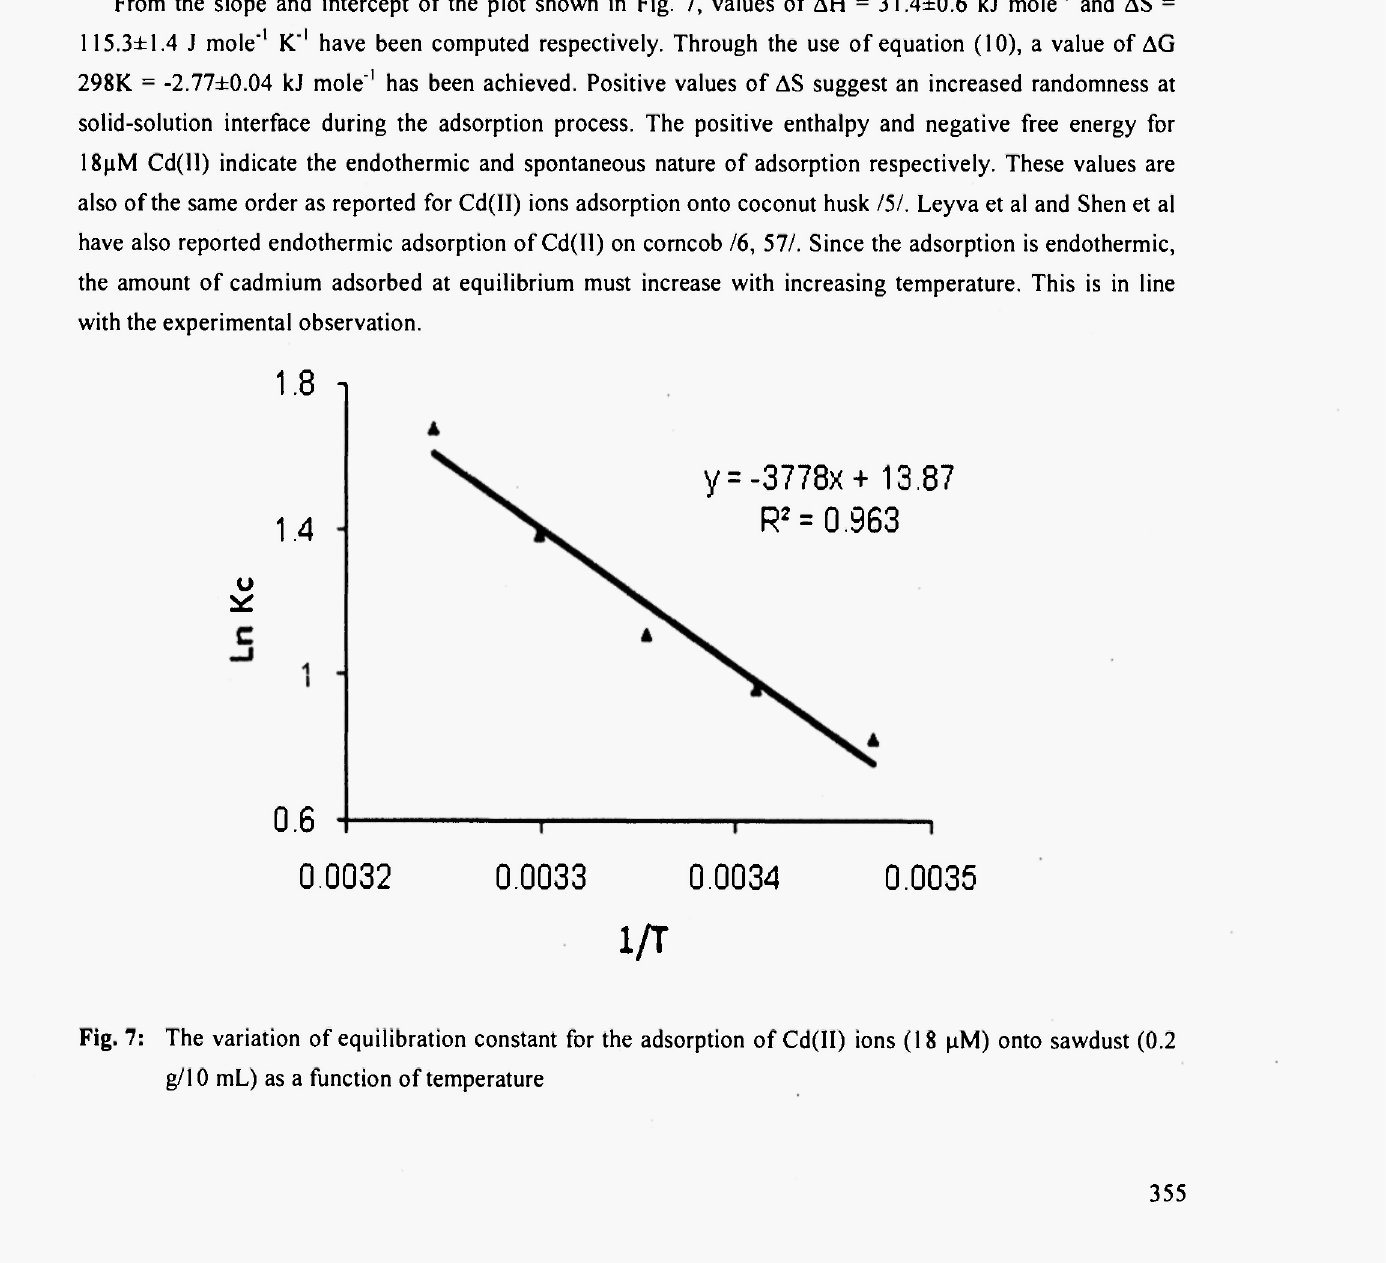
The variation of equilibration constant for the adsorption of Cd (II) ions (18 μΜ) onto sawdust (0.2 g/10 mL) as a function of temperature